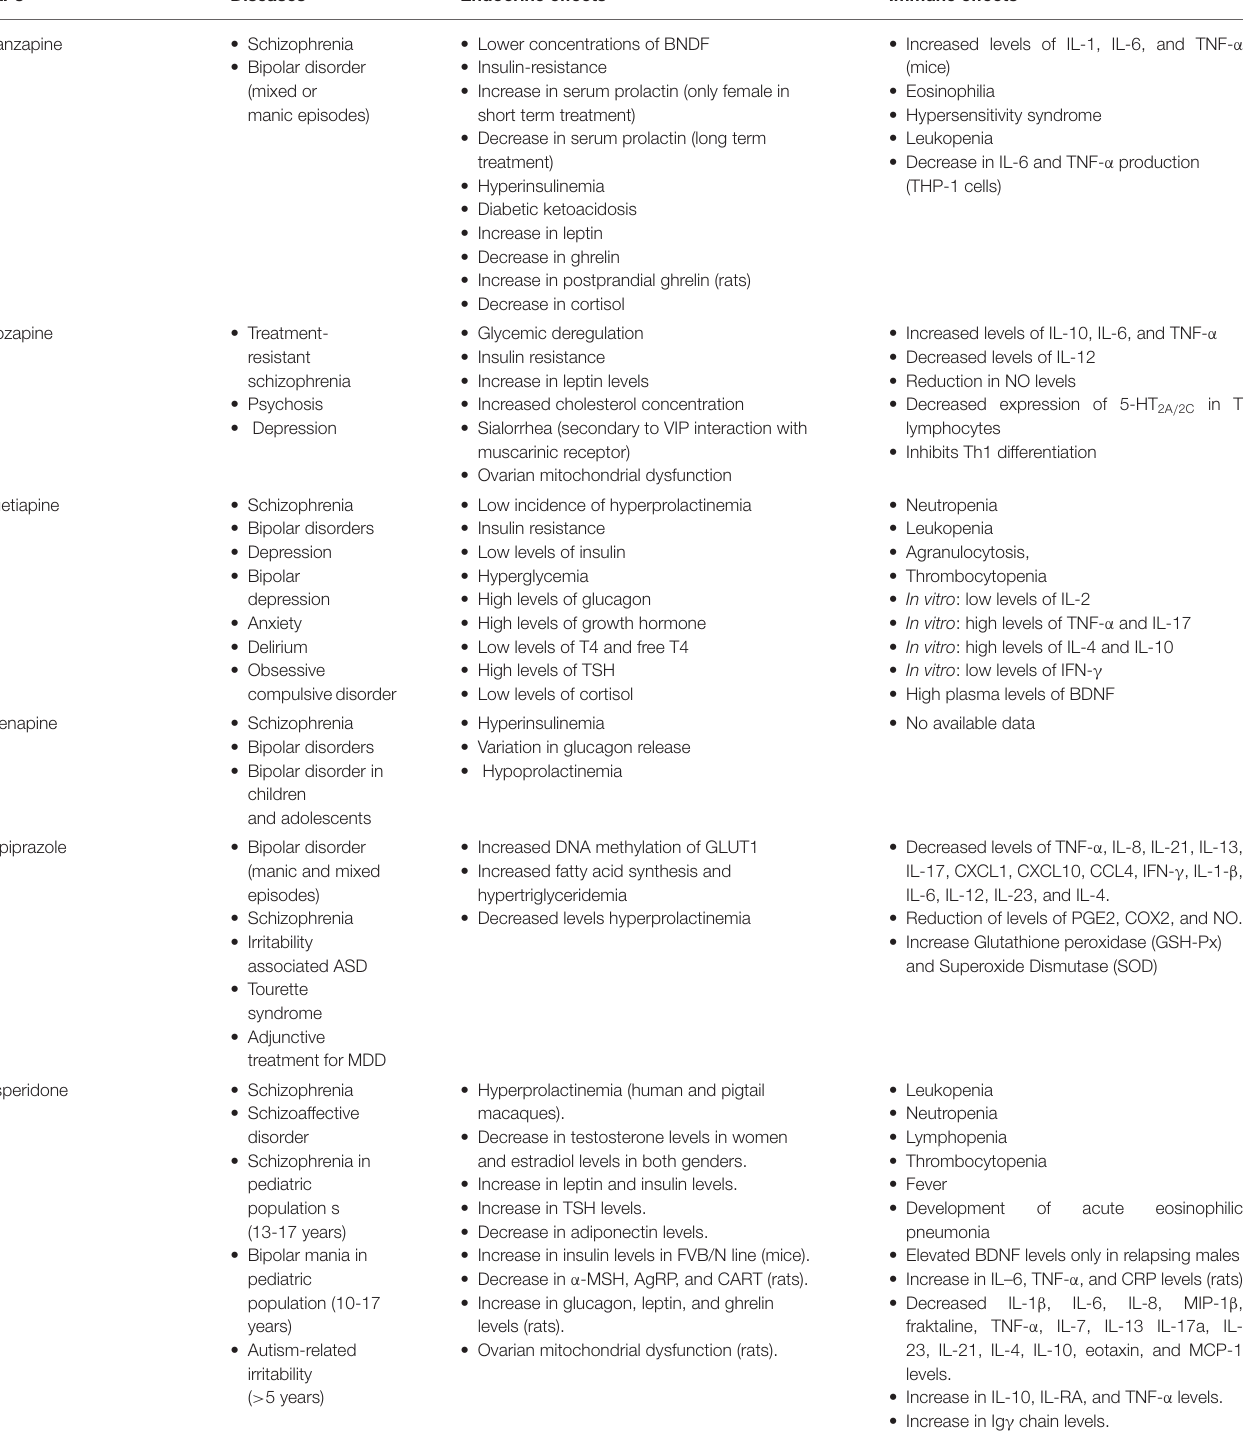
TABLE 2 | Immunoendocrine peripheral effects induced by atypical antipsychotics.